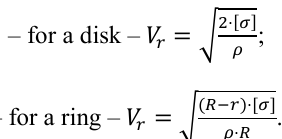
Figure 4 a nd T able 2 show t he r esults o f ho using calculations for d ifferent materials. O verall d imensions R = 125 mm; r = 38 mm.